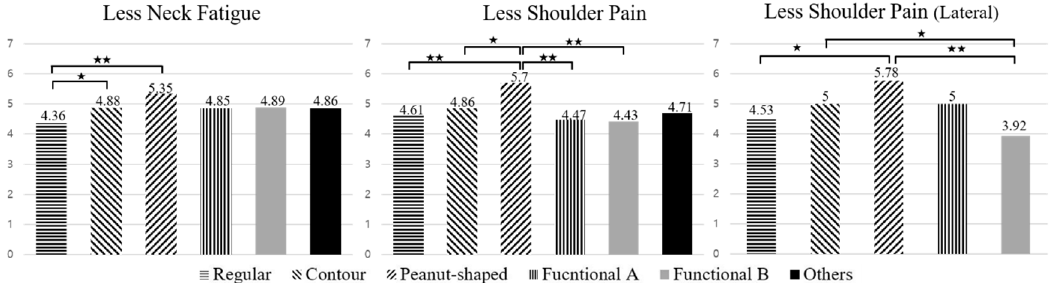
Figure 1. Post-hoc test results using Fisher’s least significant difference (LSD) method for major sleeping symptoms by pillow types ( ★★ : p < 0.01, ★ : p < 0.05).